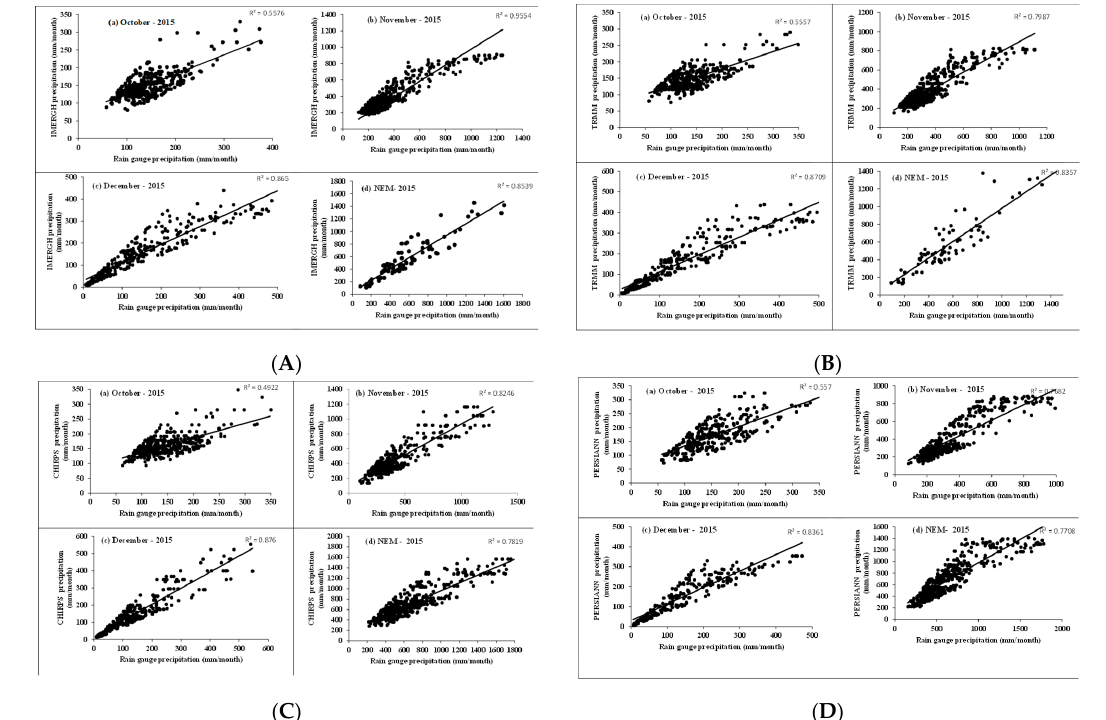
Figure 8. Scatter plots of monthly and accumulated rainfall for the year 2015 from rain-gauge stations vs. ( A ) IMERGH, ( B ) TRMM, ( C ) CHIRPS, ( D )PERSIANN at the point-based station.